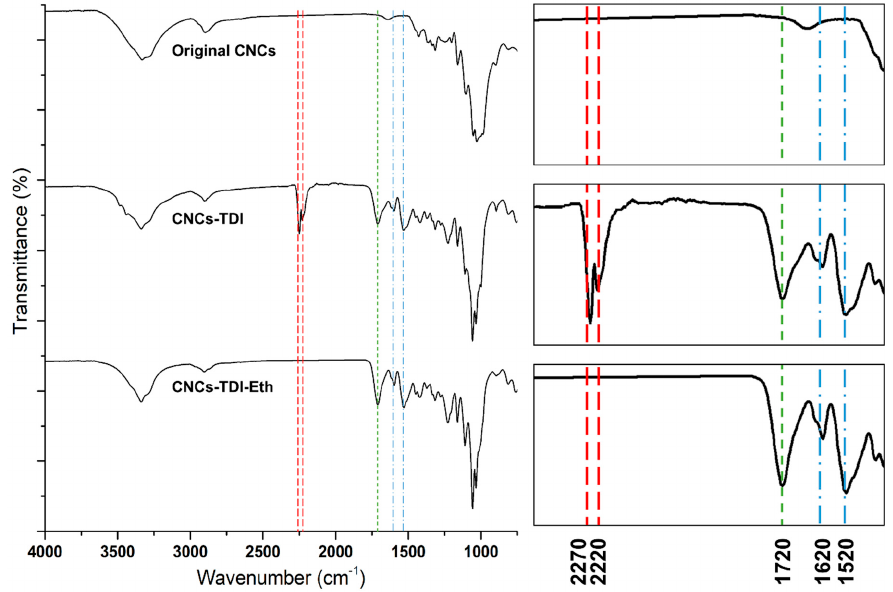
Figure 2. FT-IR spectra monitoring the structural changes in the CNCs upon TDI-carbamation and the following grafting of alcohols. The spectra on the right side are zoomed in a range of 1400–2400 cm − 1 .